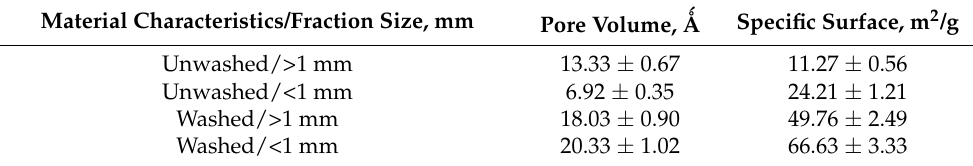
Table 2. Values of porosity and specific surface area of organic material. Material Characteristics/Fraction Size,